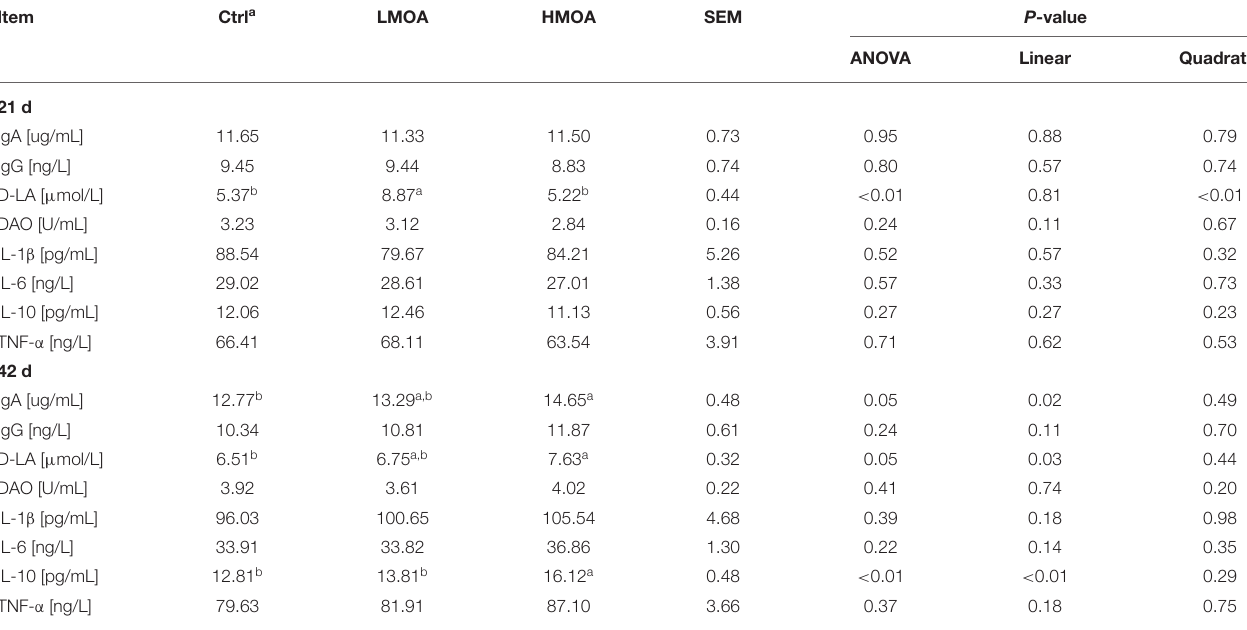
TABLE 3 | Immune function of serum in 21-day and 42-day-old broilers as affected by dietary MOA supplementation. Item